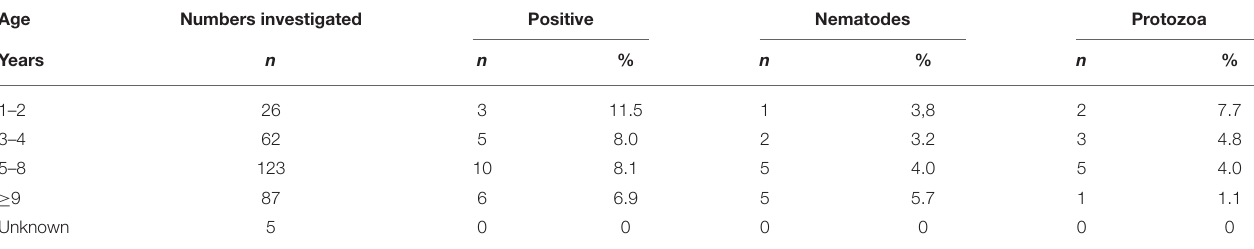
TABLE 3 | Total number of findings ( n = ) as well as proportion (%) of nematodes and protozoa per age group. Age